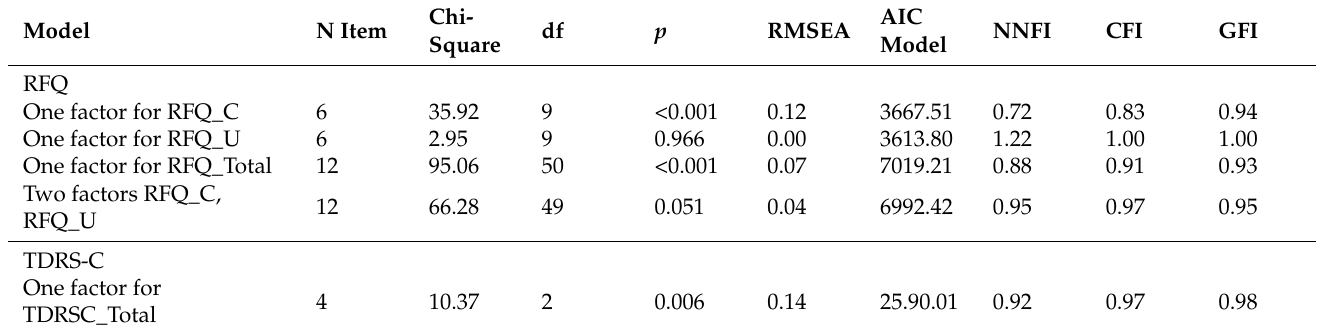
Table 3. Goodness-of-Fit Indices of Confirmatory Factor Analysis models for Reflective